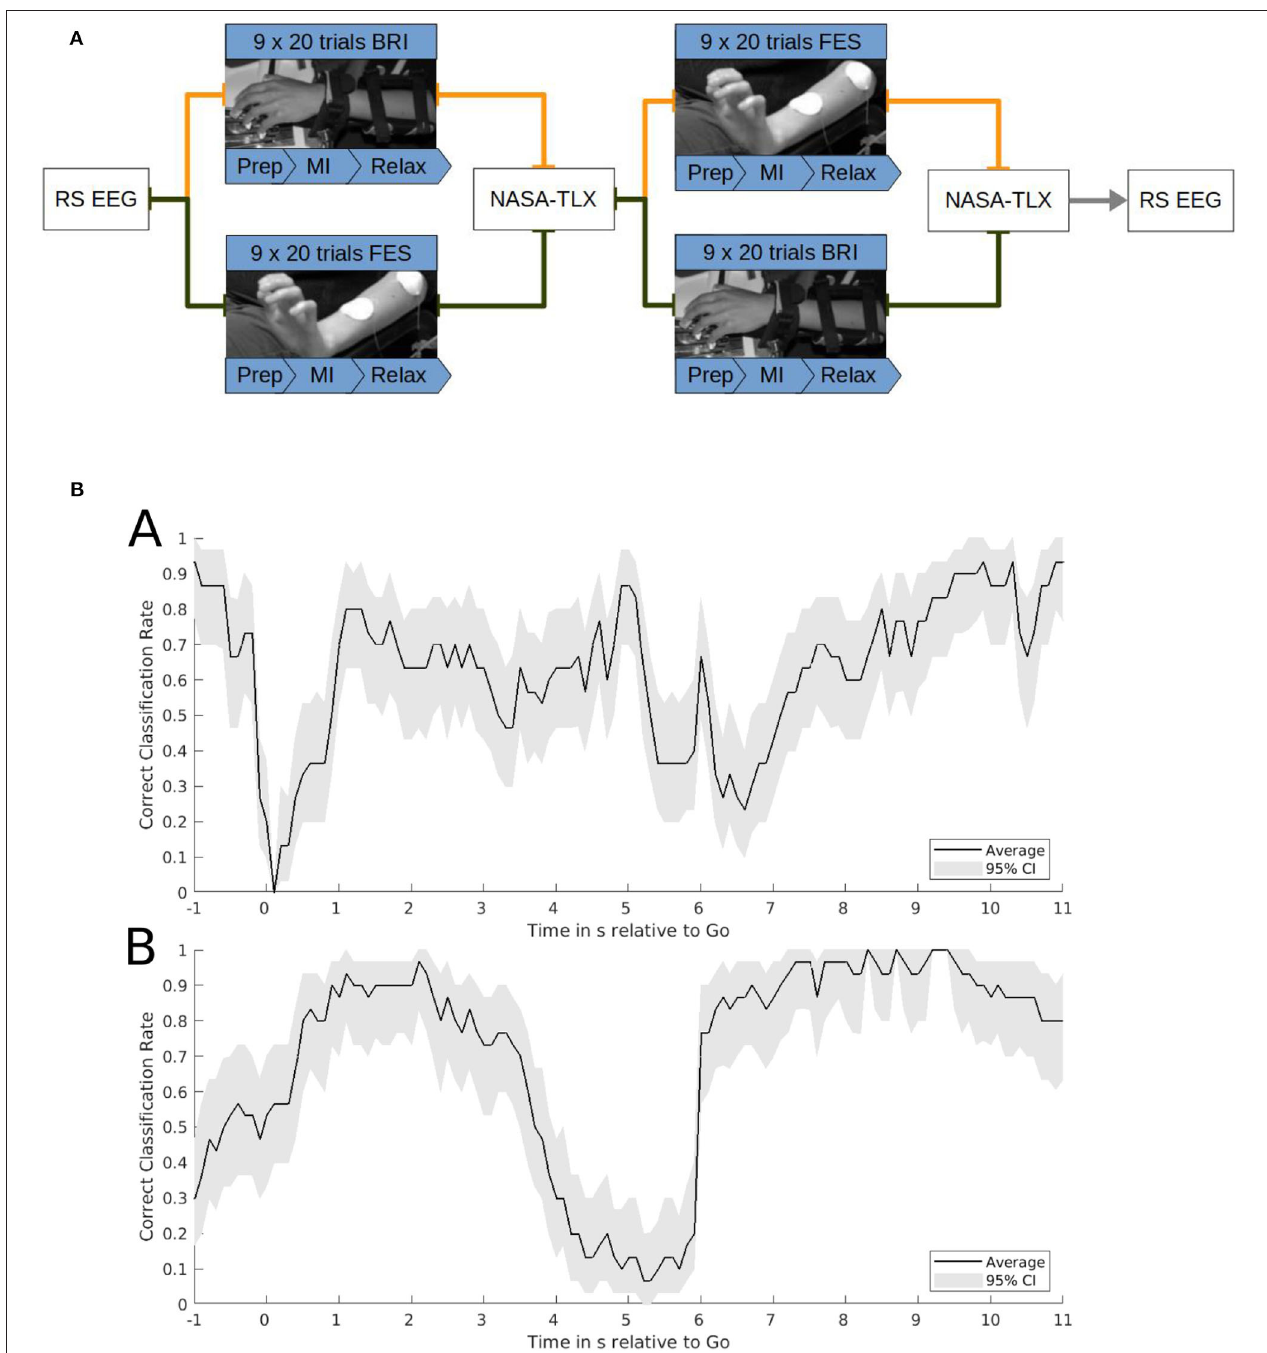
FIGURE 2 | (A) Task structure. Functional electrical stimulation (FES) and robotic feedback were applied in a cross-over block design. The FES and robotic session consisted of 9 runs with 20 trials each. Each trial included a 2-s preparation phase, a 6-s motor imagery phase and a 6-s resting phase. One session lasted until at least 120 feedback onsets were reached. After each block subjects completed a NASA-TLX questionnaire. Before and after the intervention a resting state EEG was recorded. The study lasted ∼ 3h. (B) Correct classification rate (CCR). Exemplary single subject data of the CCR of brain-machine interface control with robotic feedback (a) or functional electrical stimulation (b). Time on the x-axis is relative to the go-cue for motor imagery at 0s and the relax-cue at 6s. The CCR on the y-axis indicates the probability of classifying the sample correctly as motor imagery after the go-cue or as rest after the relax-cue. It is calculated on the basis of a smoothened time course averaged over 30 trials with 95% confidence intervals estimated by bootstrapping.